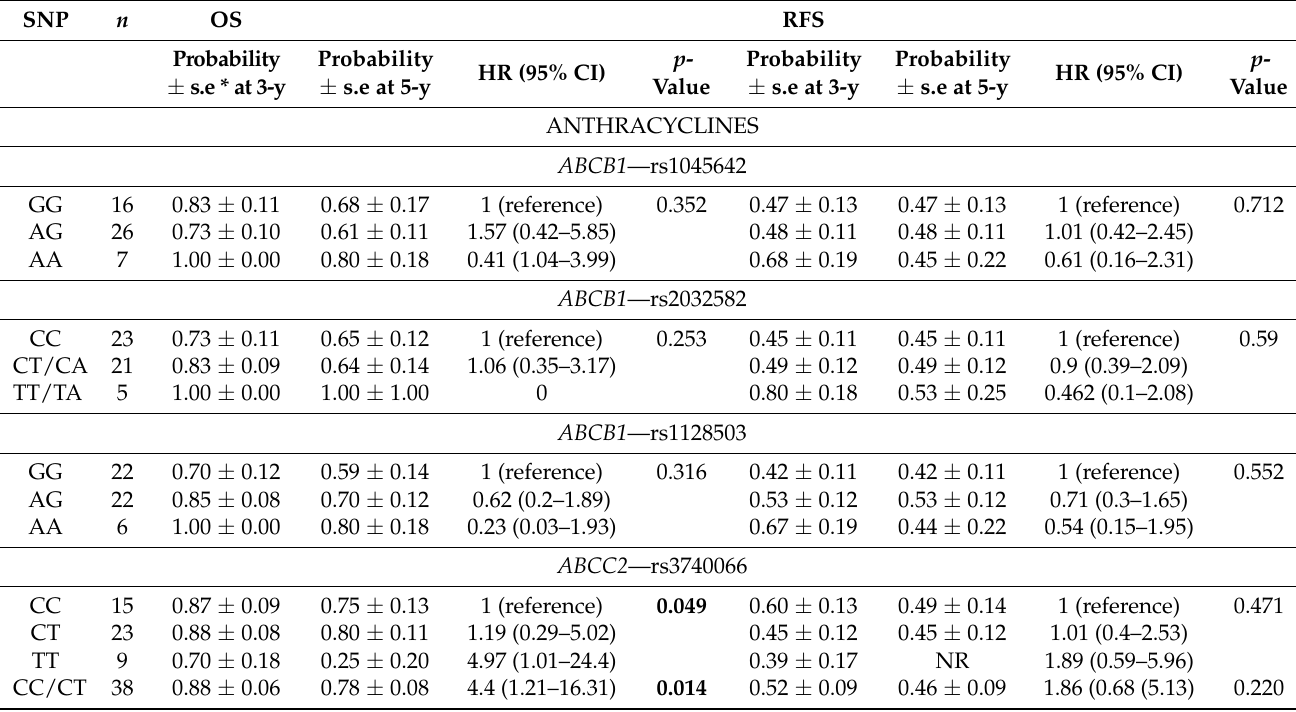
Table 4. Univariate associations between genetic variants and overall survival (OS) and recurrence- free survival